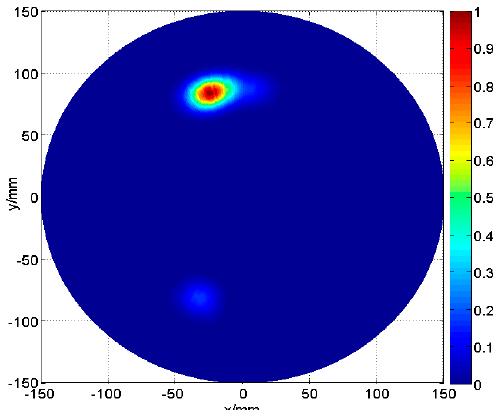
Figure 13. Damage imaging after the enhancement of the cross-array image.